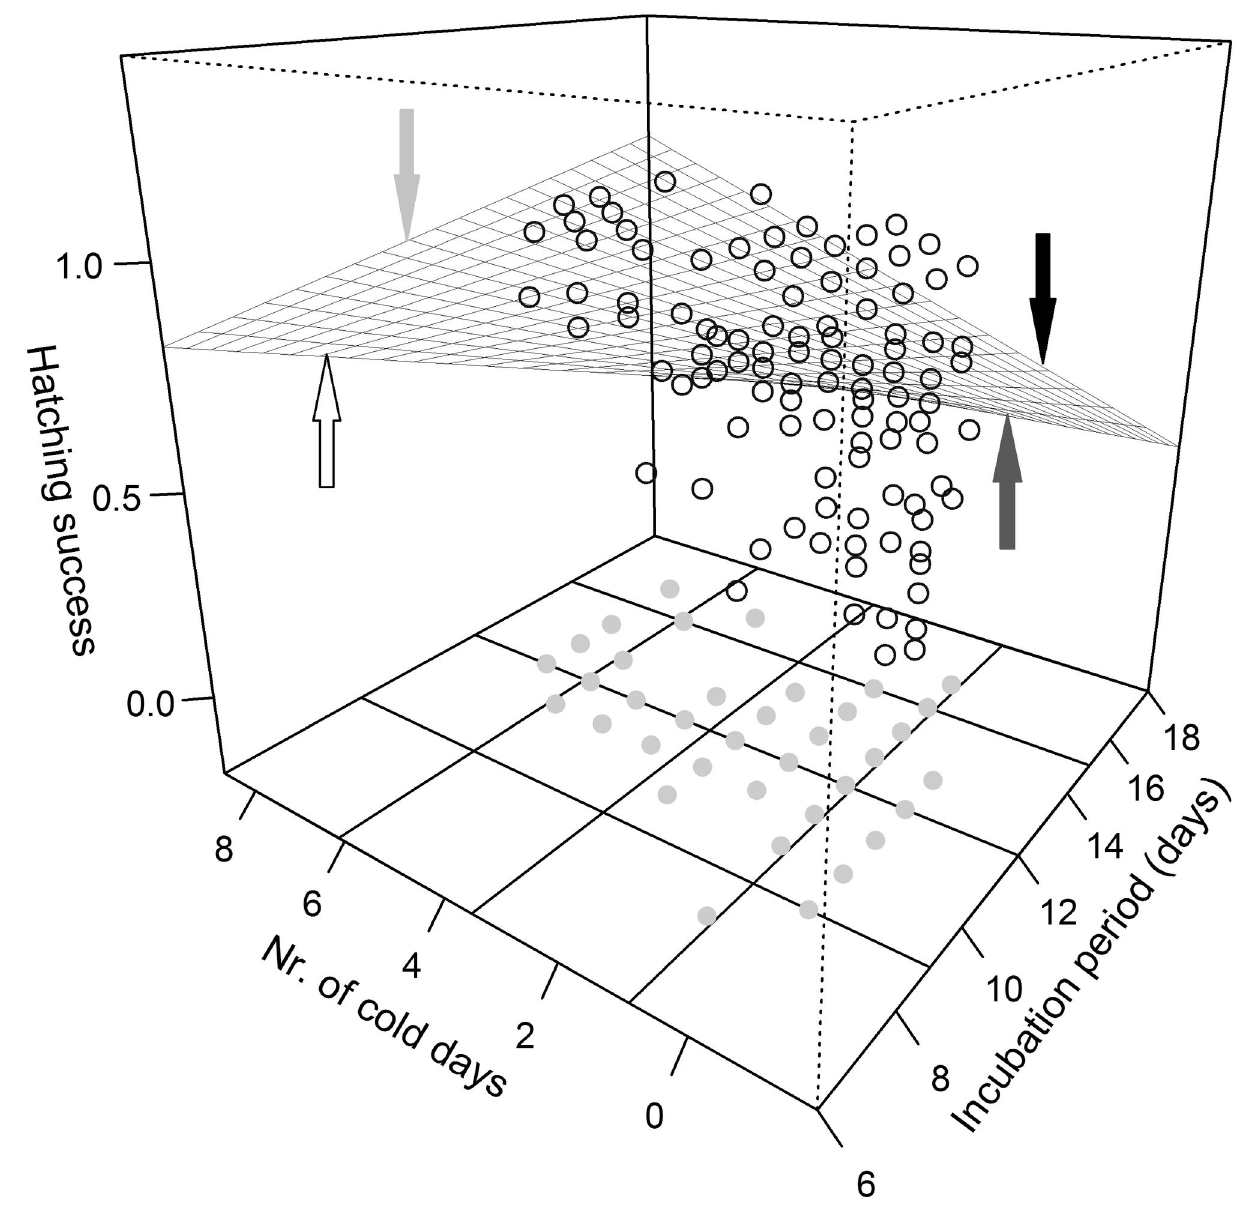
Figure 3. Relationship of hatching success with the number of cold days and length of incubation period. The warped regression plane was fitted from a linear regression to illustrate the interacting effects of the two predictors on hatching success. Open circles are the data points in 3D space defined by the three variables. Grey dots on the bottom grid of the graph show the relationship between the number of cold days and length of incubation period. Arrows highlight the slopes of the relationships between hatching success and number of cold days when incubation is short (white) or long (black), and between hatching success and length of incubation when number of cold days is high (light-grey) or low (dark-grey).